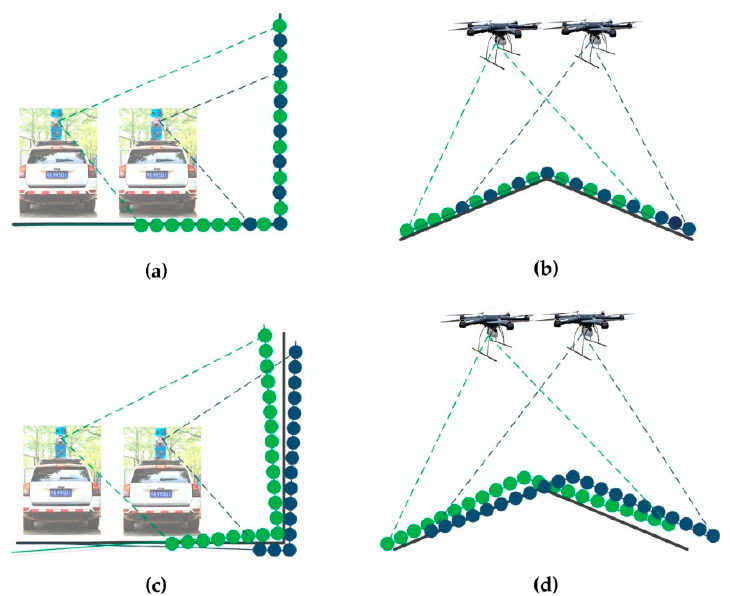
Figure 4. Effect of the measuring errors for multi-strip point clouds from the MLS and ULS systems. ( a , b ) multi-strip point clouds coincide with each other perfectly when no errors exist; ( c , d ) there are misalignments among the multi-strip point clouds because of errors. Points scanned from different strips are colored by different colors.